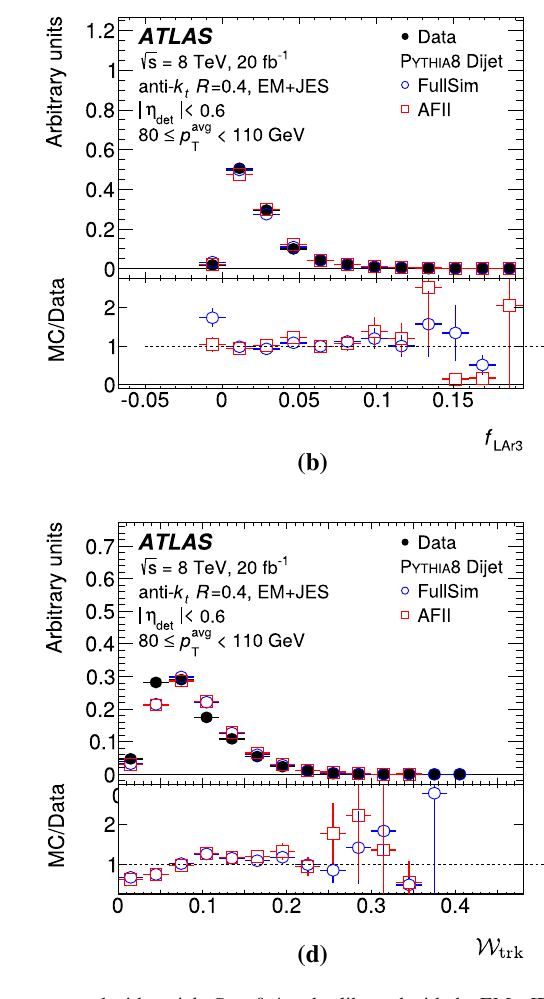
structed with anti- k t R = 0 . 4 and calibrated with the EM+JES scheme. < 110GeV in The quantity p avg is the average p T of the leading two jets in an event, T T andhencerepresentthe p T scaleofthejetsbeingprobed. N segments isnot shown since the vast majority of jets in this p T range have N segments = 0